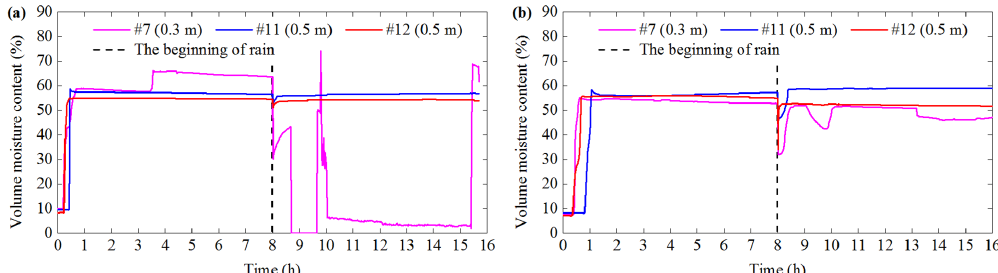
Figure 9. Volume moisture content at position D and E of (a) test 3 and (b) test